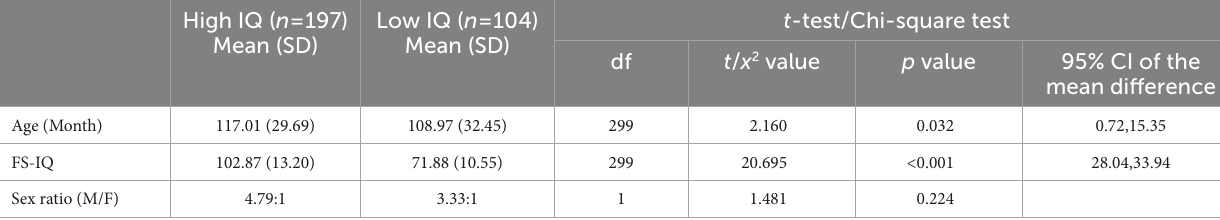
TABLE 2 Individual characteristics of children with ASD in different IQ groups.